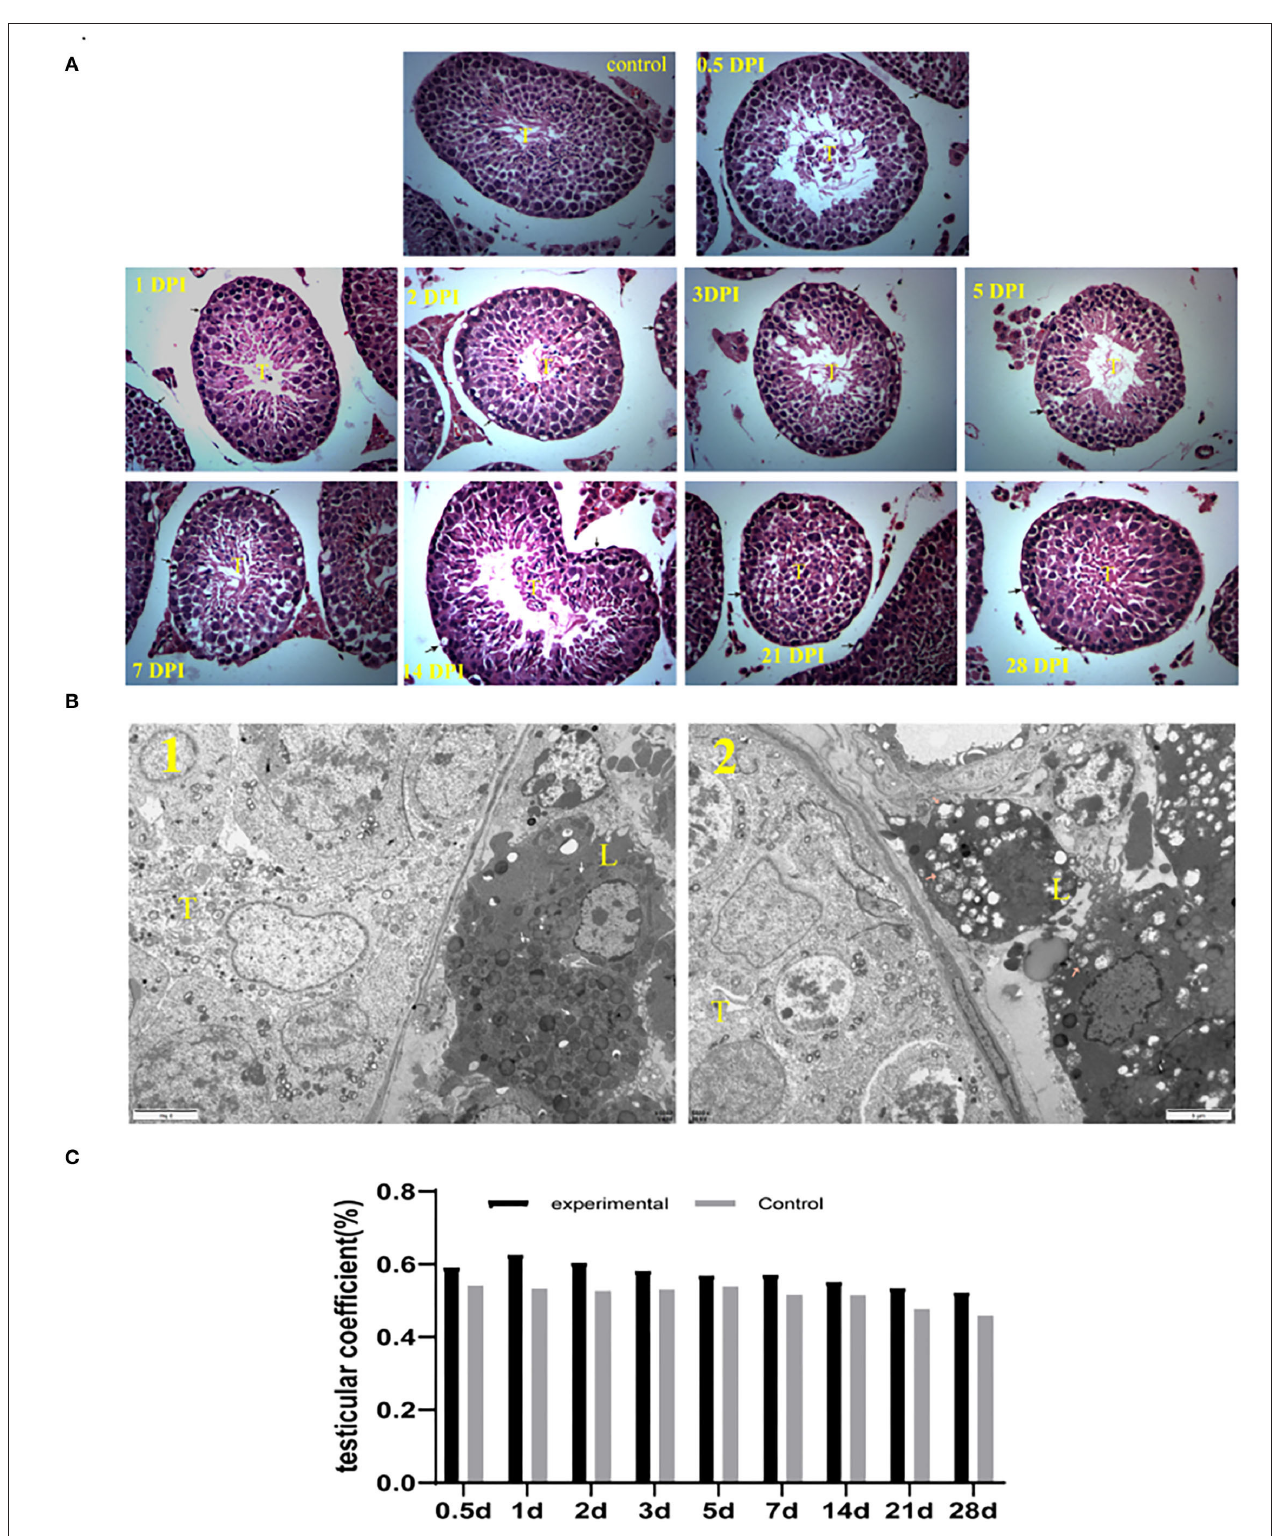
FIGURE 2 | (A) Histological (HandE) staining of testes tissue sections (40 × 10). (control) Control testes from the control mice were given an injection with PBS at 7 dpi. The other is GETV-infected testes at 0.5 dpi-28 dpi. cavitation in spermatogonia and spermatocyte (arrows), T indicates lumens of seminiferous tubules. (B) The testis’s transmission electron microscope photograph 1: the control mouse; 2: the GETV-infected mouse. The pink arrow in B: normal mitochondria in Leydig cells. The pink arrow in B: Swollen mitochondria in Leydig cells. (C) Changes in testicular coefficient after infection of the GETV mice over time.